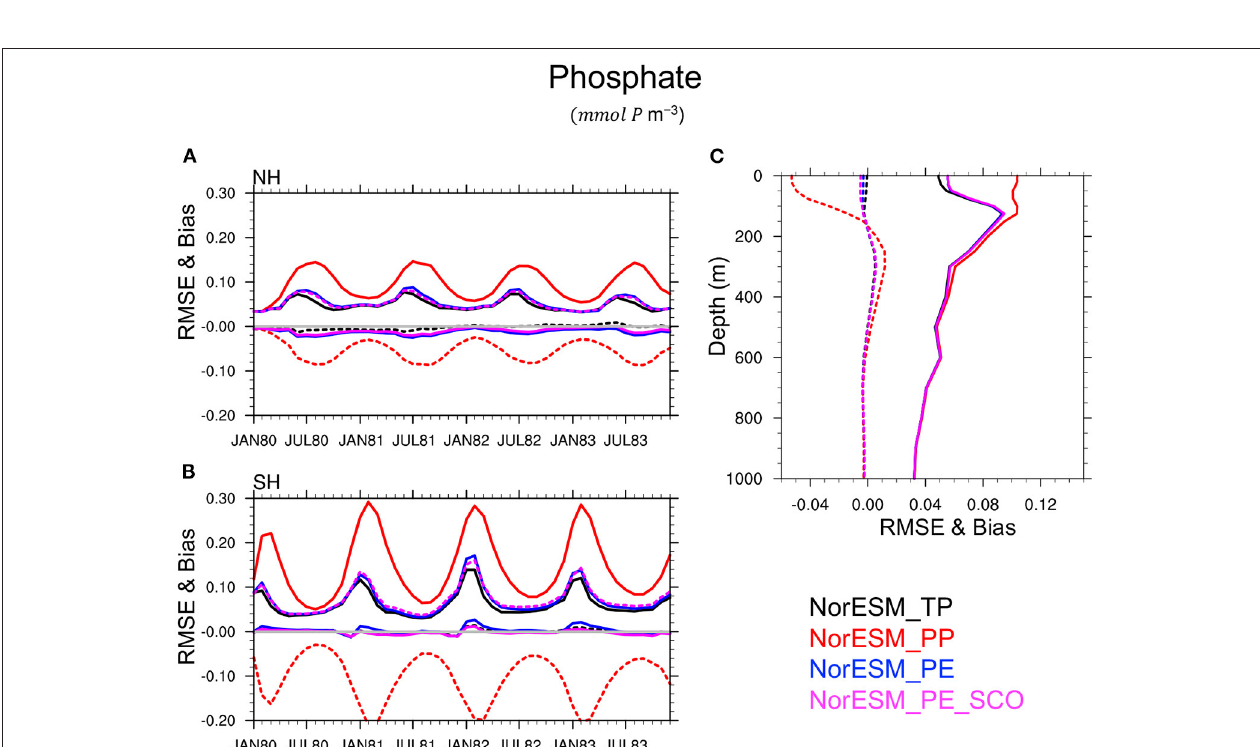
FIGURE 9 | Same as Figure 7 but for